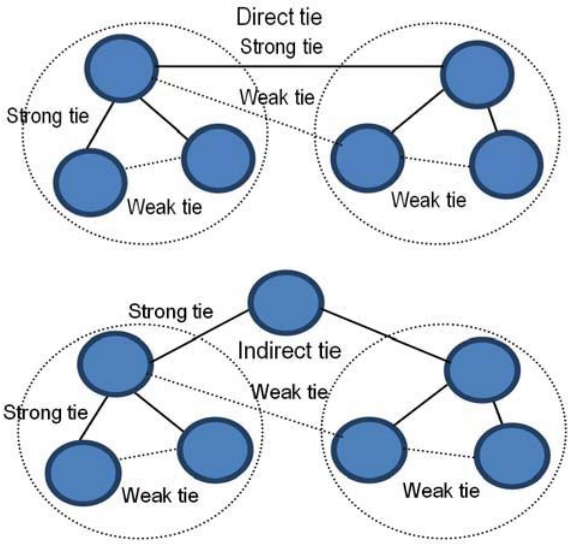
Fig. 1. Illustration of both weak and strong ties within and be- tween two groups